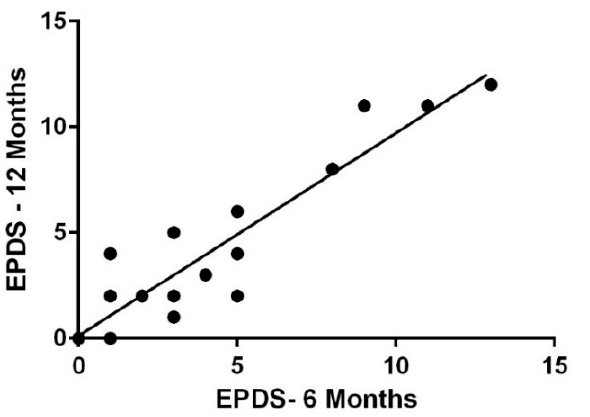
Figure 1. EPDS Scores at Six Months Postpartum compared to EPDS Scores at 12 Months Postpartum.